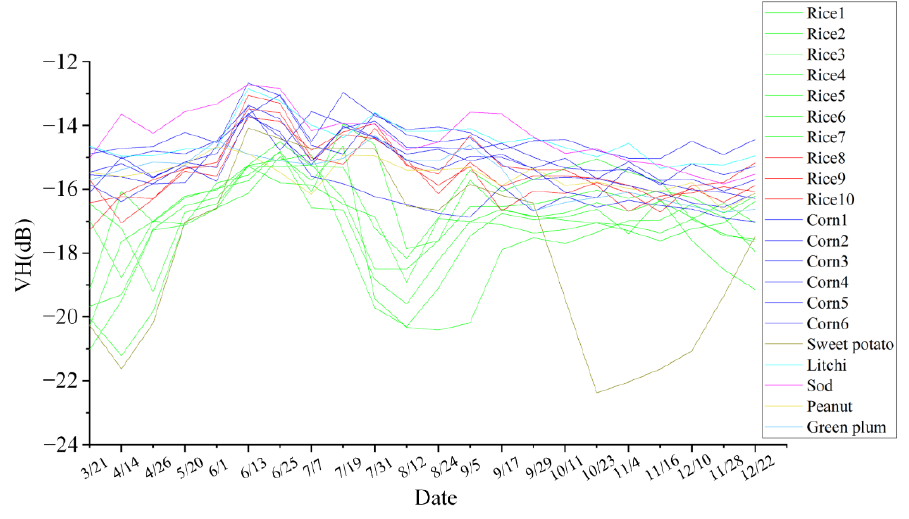
Figure 4. Crop time series of VH polarization for 21 field survey areas. (A total of seven crops, respectively, rice, corn, sweet potato, litchi, sod, peanut, green plum).